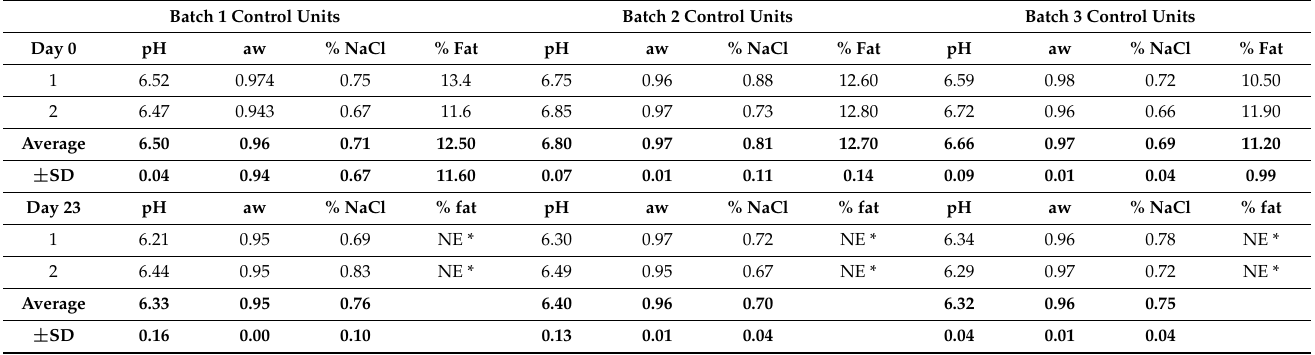
Table 5. Physico-chemical characteristics of the Anthotyros cheese (control units), at “Day 0” and at the end of shelf life,